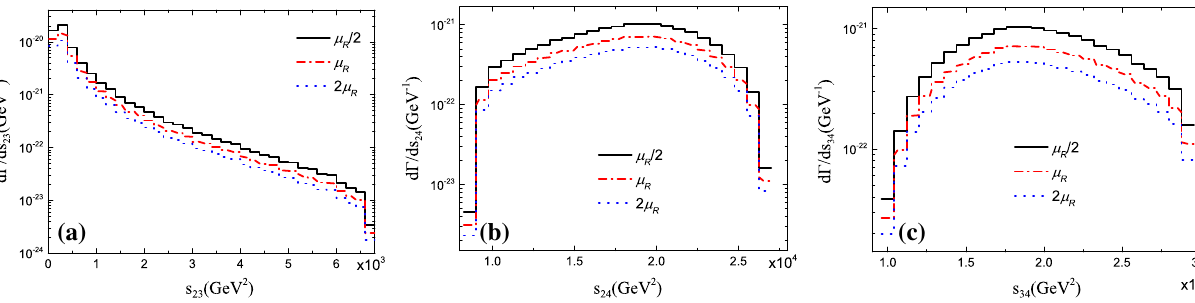
Fig. 5 The differential decay width d (cid:2)/ ds 23 ( a ), d (cid:2)/ ds 24 ( b ) and d (cid:2)/ ds 34 ( c ) with renormalization scale uncertainty for t → | ( c ¯ b ) [ n ](cid:5)+ b + Z